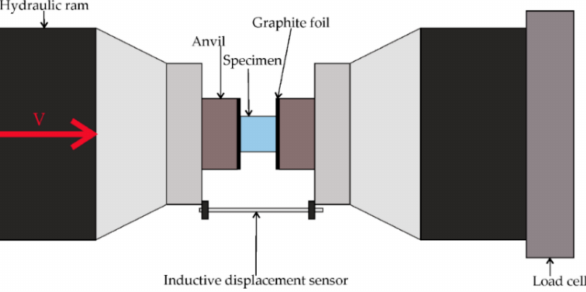
Figure 2. Experimental setup for the obtainment of JC material